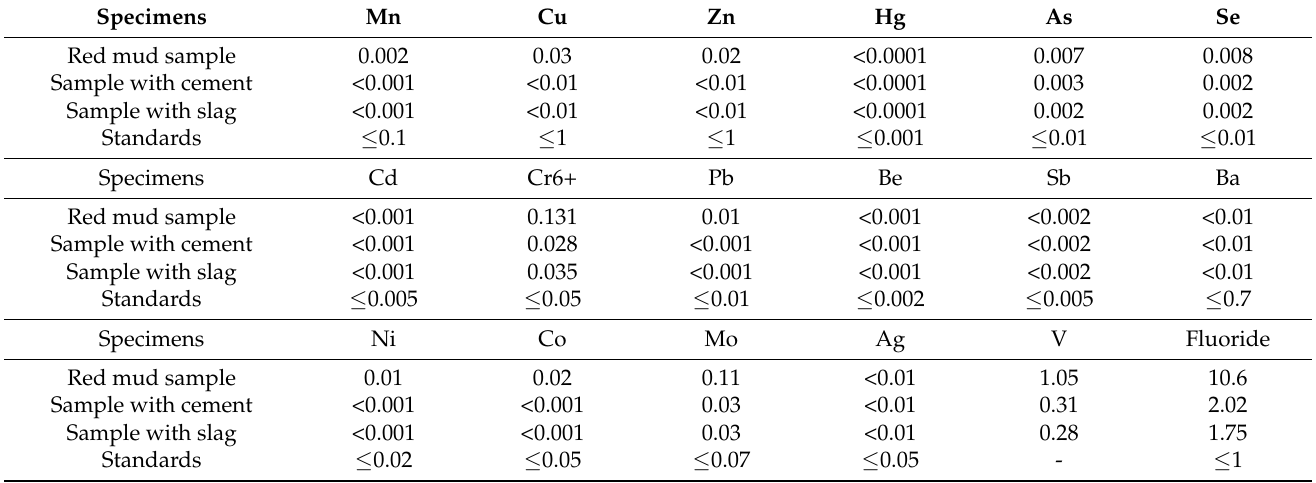
Table 3. Elements’ contents in leaching water